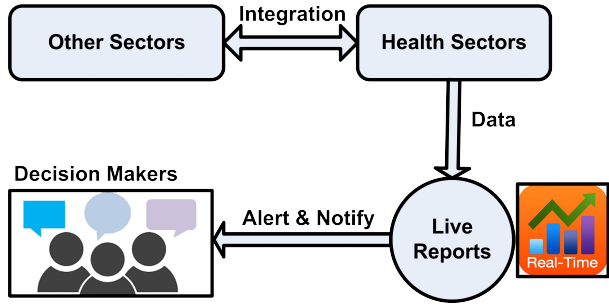
Figure 3. Pandemic real-time management